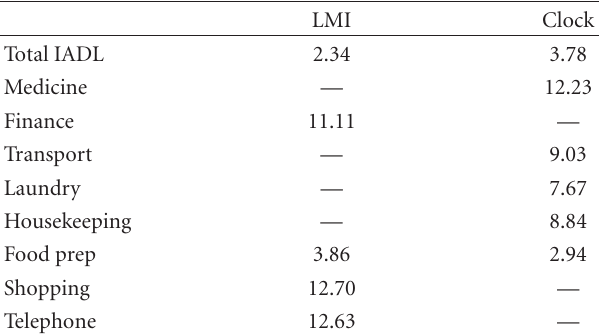
Table 3: t values of significant predictors of ADLs in men and women.